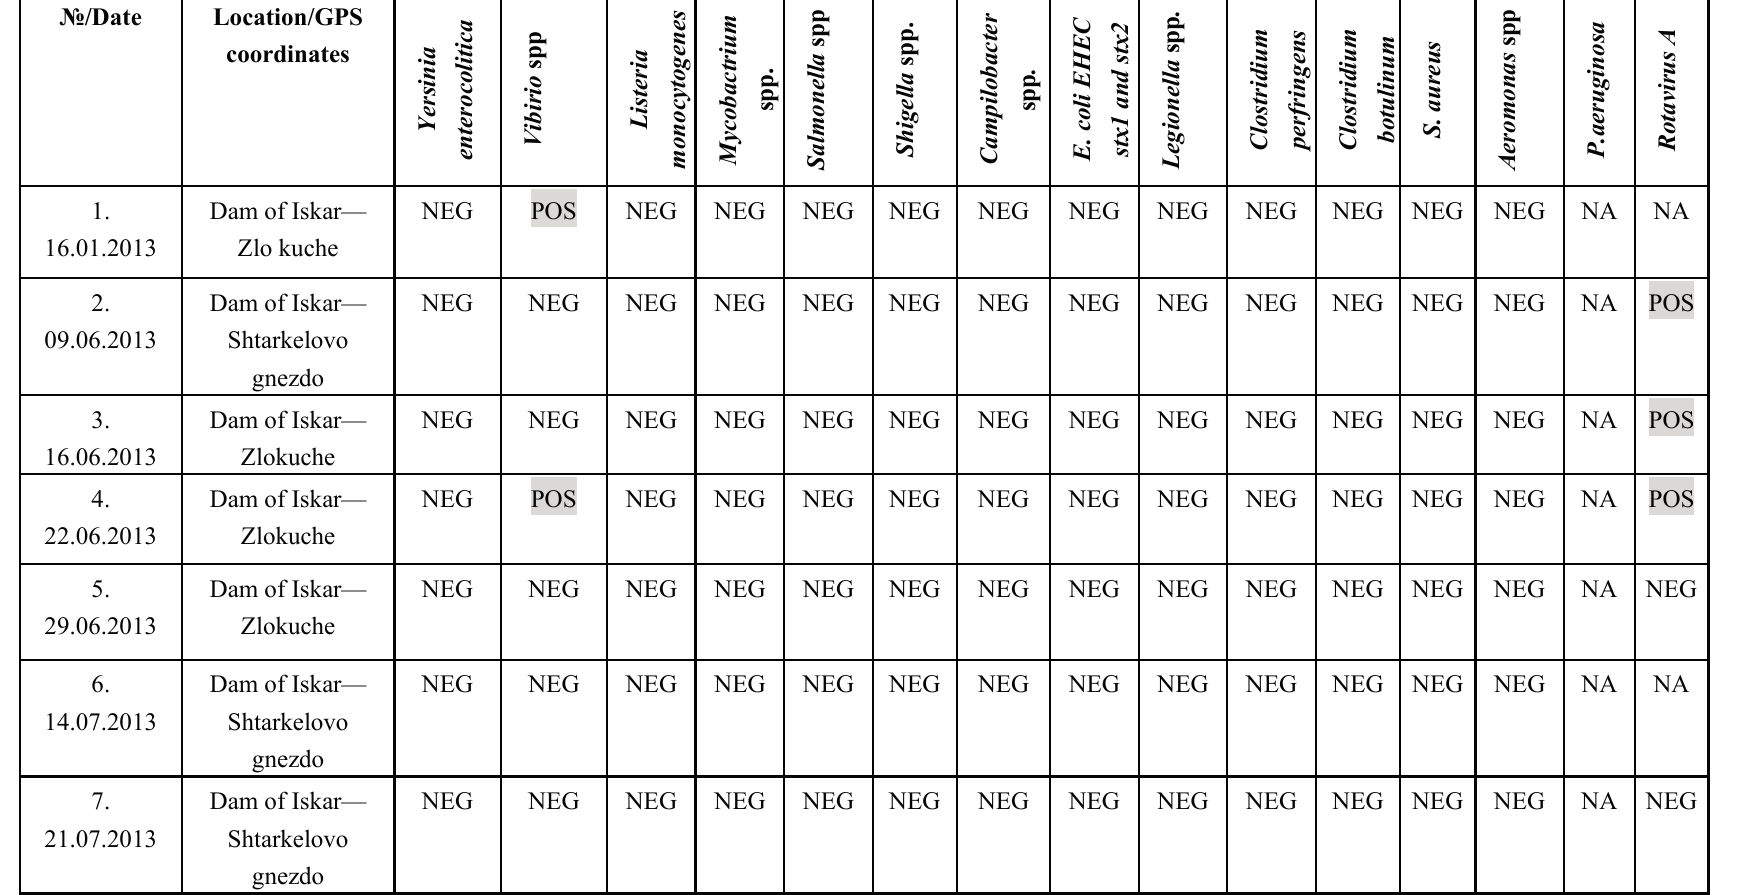
Table A1. List of water samples collected from the Black Sea and the Dam of Iskar between 26.06.2012–07.02.2014. Sampling coordinates and results of detected pathogens. NA—result not available; Black Sea—Rezovo village 41 o 58 ’ 57.76 ” N 28 o 1 ’ 54.00 ” E; Black